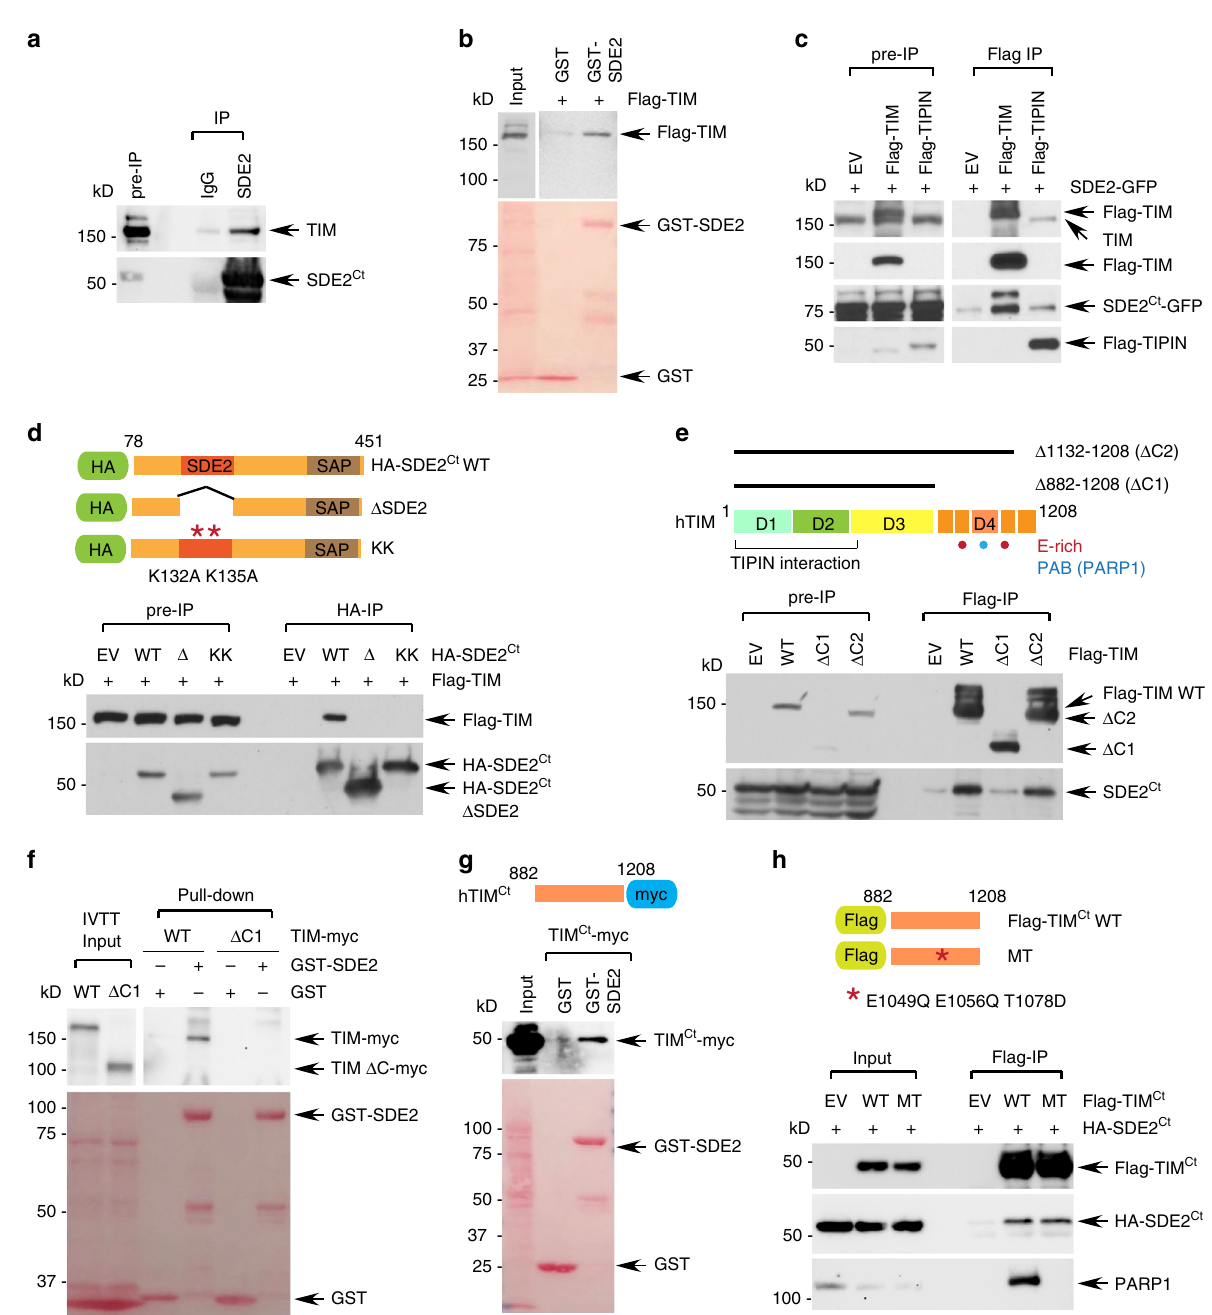
Fig. 2 SDE2 directly interacts with the C-terminus of TIM. a Co-immunoprecipitation (IP) of both endogenous SDE2 and TIM in U2OS cells using an SDE2 antibody (vs. rabbit IgG control). b GST pull-down of 293T cell lysates expressing Flag-TIM with puri fi ed GST or GST-SDE2. c Anti-Flag co-IP of Flag-TIM or Flag-TIPIN with SDE2-GFP in 293T cells. EV: empty vector. d Anti-HA co-IP of Flag-TIM with HA-SDE2 Ct wild-type (WT), Δ SDE2, or KK (K132A/ K135A) mutant in 293T cells. Schematic of HA-SDE2 construct variants is shown above. e Anti-Flag co-IP of Flag-TIM WT, Δ 882-1208 ( Δ C1), or Δ 1132- 1208 ( Δ C2) with endogenous SDE2. Schematic of human TIM is shown above. D1-D4 indicates four domains classi fi ed as previously described. The TIM C-terminus referred in this study is indicated in orange. Red dot: Glu-rich regions. Blue dot: PARP1-interacting region, PAB, or D4. f GST pull-down of in vitro transcribed and translated (IVTT) TIM-myc WT or Δ C1 mutant with puri fi ed GST or GST-SDE2. g GST pull-down of 293T cell lysates expressing TIM C-terminus (Ct; aa882-1208)-myc with puri fi ed GST or GST-SDE2. h Anti-Flag co-IP of Flag-TIM Ct WT or PARP1-binding mutant (MT: E1049Q/ E1056Q/T1078D) either with HA-SDE2 Ct or endogenous